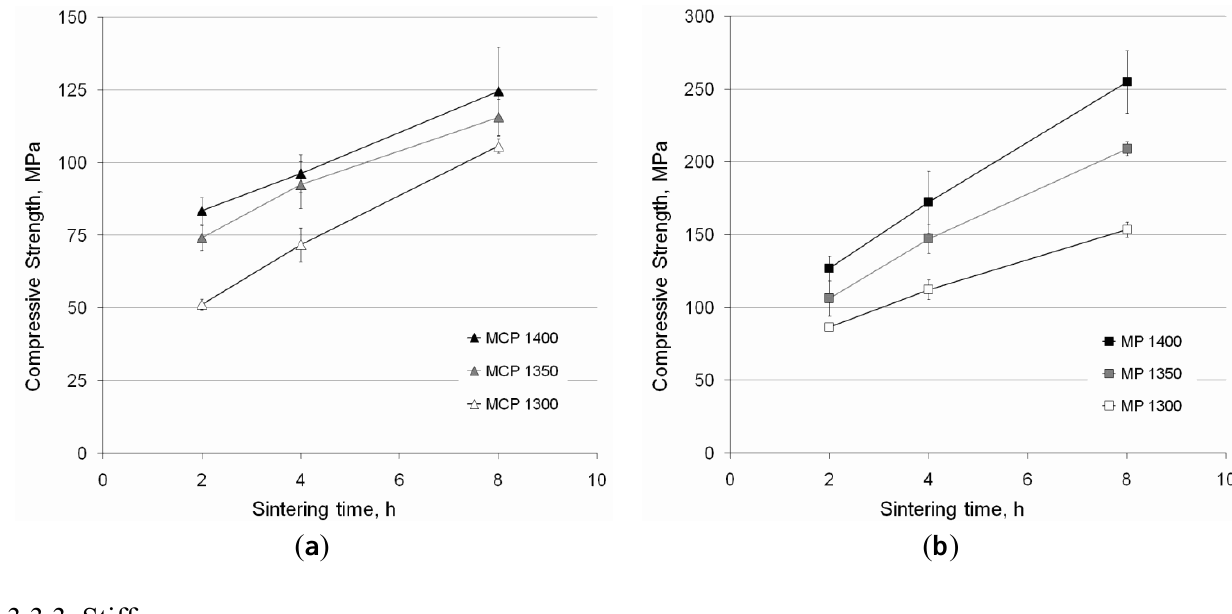
Figure 7. Compressive strength and standard deviation of the porous samples developed